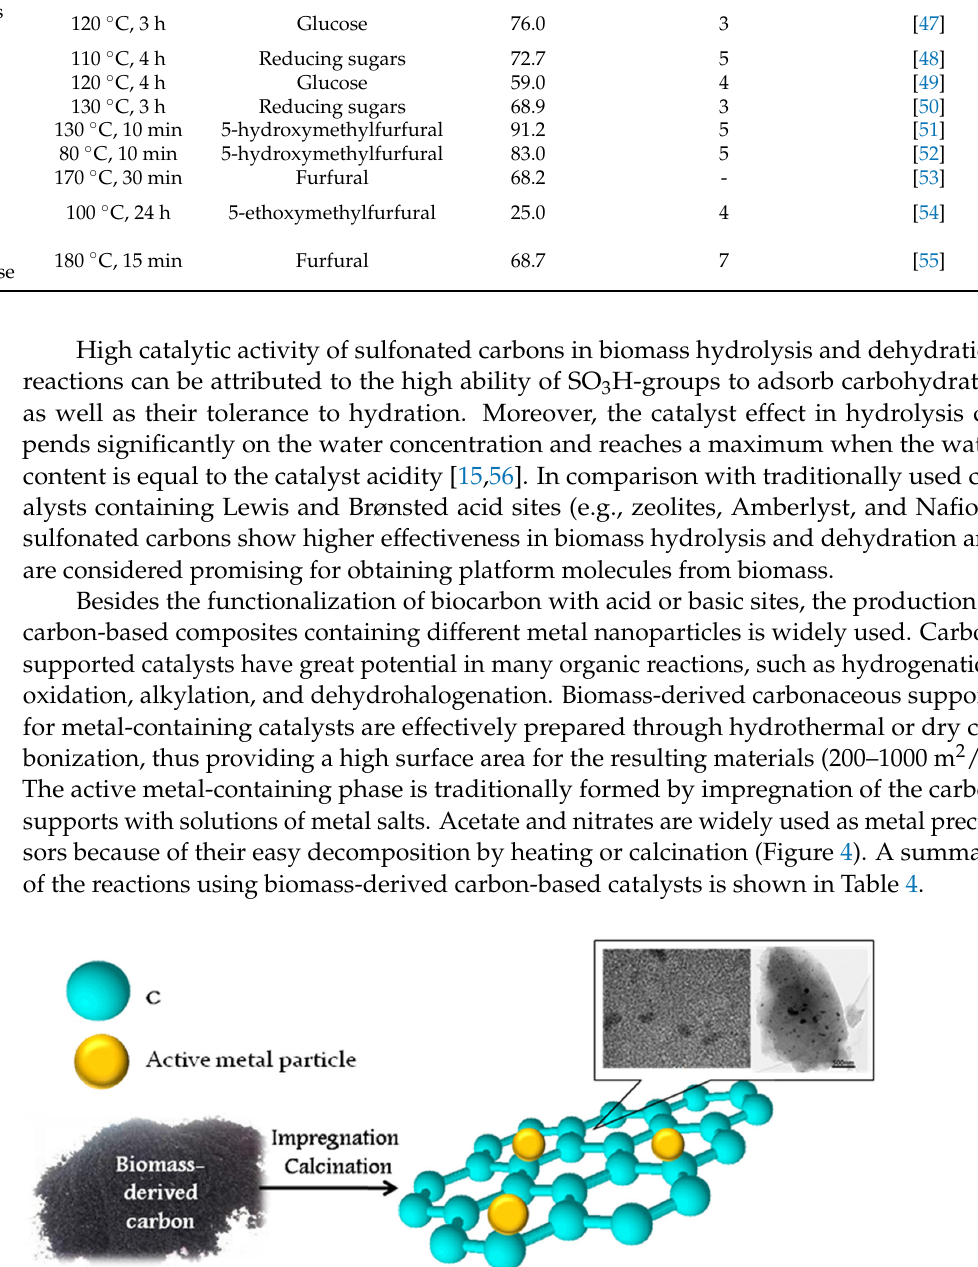
Table 3. Sulfonated carbon ‐ based catalysts for biomass conversion.